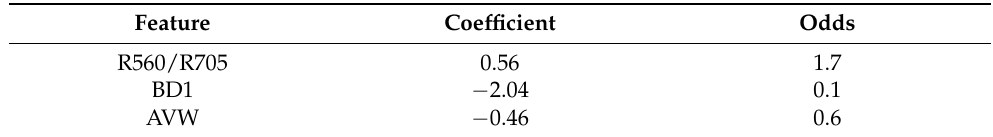
Table 7. The coefficients and odds of the features included in the logistic regression model to predict Clear